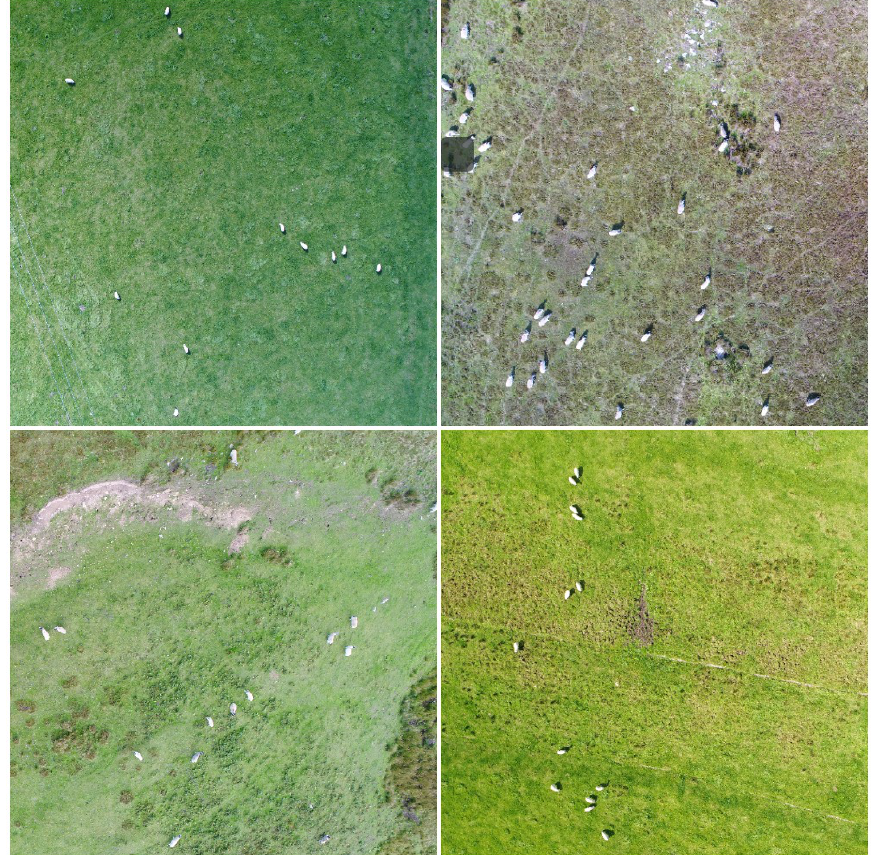
Figure 9. Example images of the livestock dataset. In the images, sheep are small targets for the object